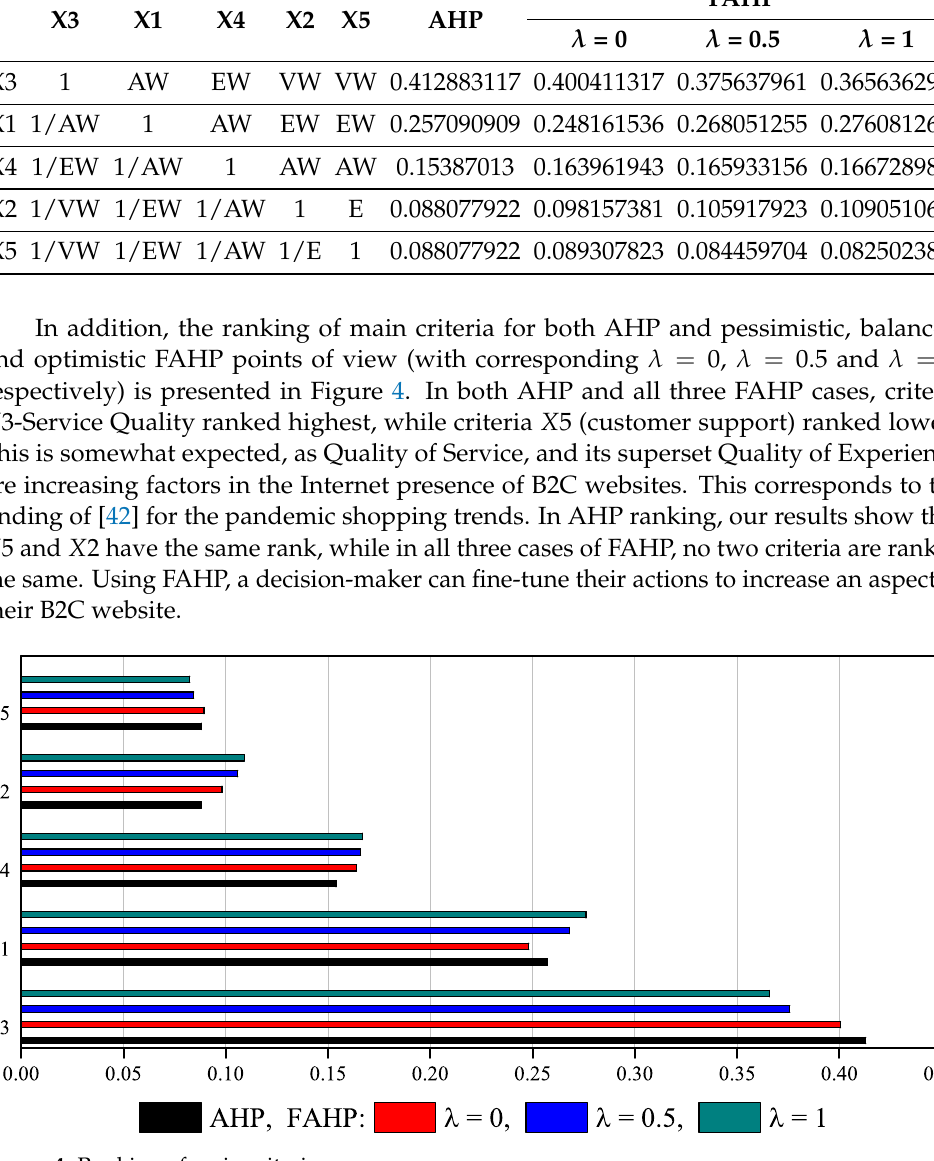
Figure 4. Ranking of main